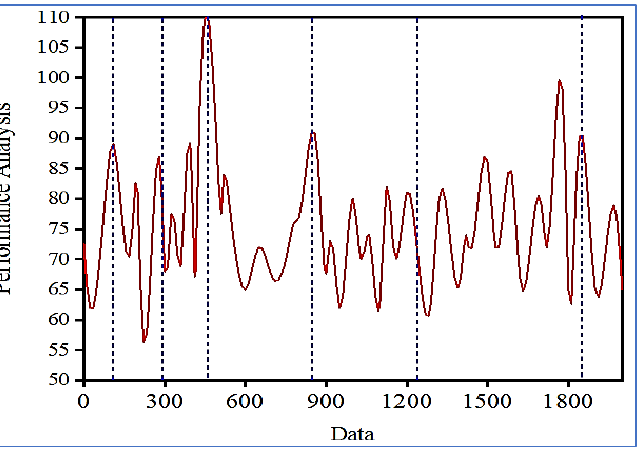
Figure 2. Performance analysis for the data movement segmentation of agricultural higher vocational courses based on a BP Neural network. The increased value represents the initial point so that if the variability is not quite so large, indicating a relatively smooth transition, it represents the data movement point.